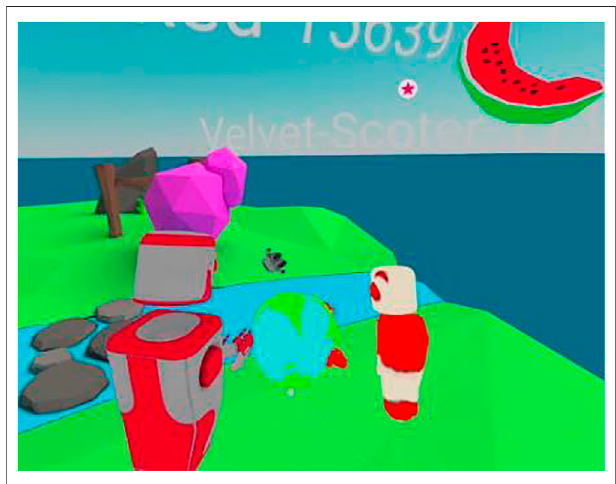
FIGURE 1 | Two people interacting with an earth model in Mozilla Hubs.